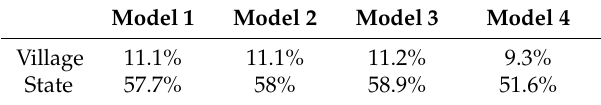
Table A2. Percent of variance attributable to village and